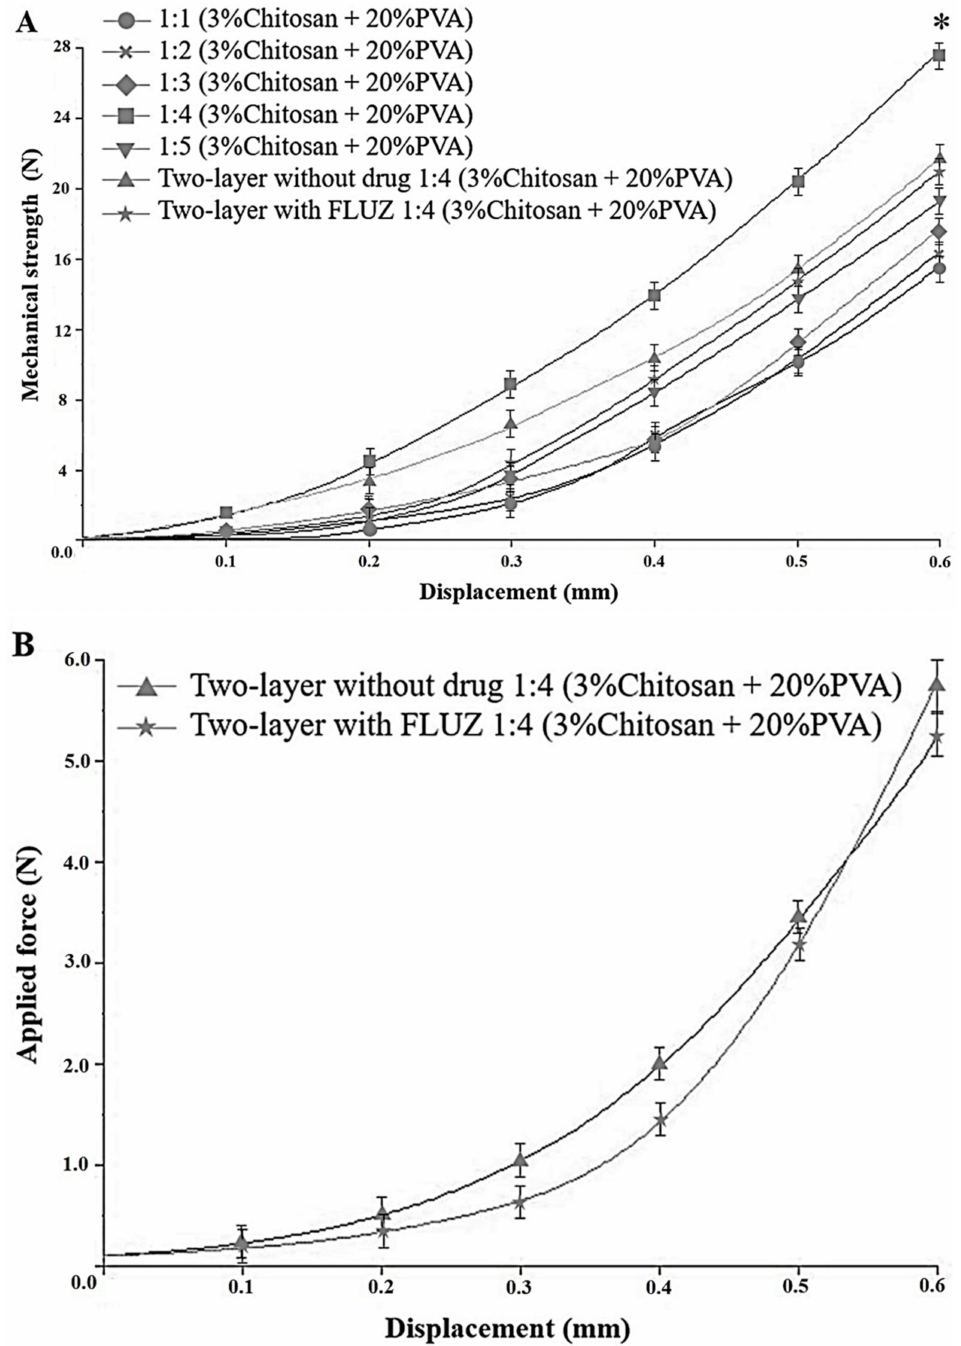
Figure 5. ( A ) Mechanical strength and ( B ) insertion force of optimal FLUZ-MEs-loaded two-layered dissolving MNs. * indicates significant differences from others ( p <